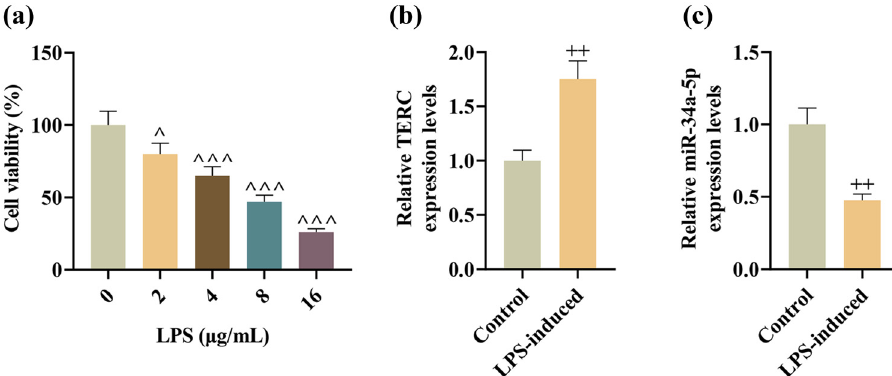
Figure 2: TERC level was upregulated while miR - 34a - 5p level was downregulated in LPS - induced PC - 12 cells. ( a ) The viability of PC - 12 cells after treatment with di ff erent concentrations of LPS was measured by CCK - 8 assay. ( b and c ) The expressions of TERC and miR - 34a - 5p in LPS - induced PC - 12 cells were analyzed by qRT - PCR. ^ P < 0.05, ++ P < 0.01, ^^^ P < 0.001; ^ vs 0; + vs